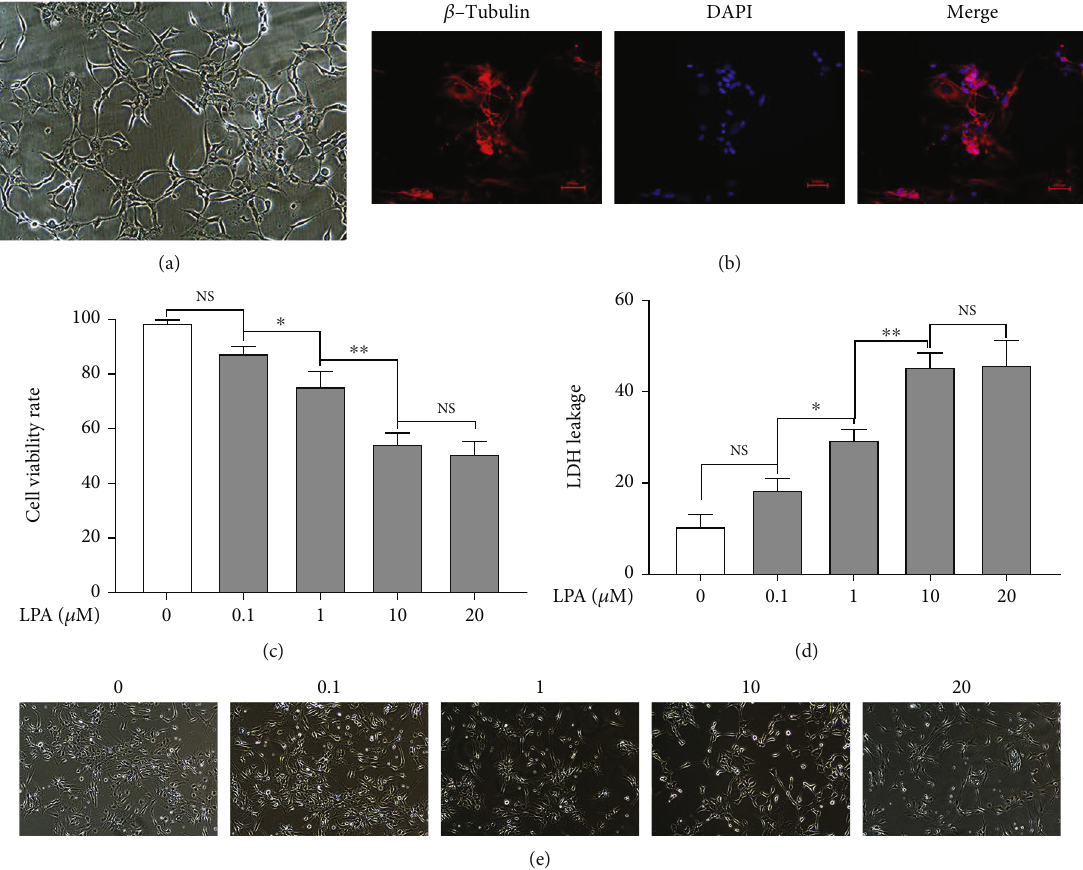
Figure 2: LPA e ff ects on cell viability and cytotoxicity in spinal cord neurons. (a) Observation of primary spinal cord neurons with microscope (100x). (b) The expression of β -tubulin in spinal cord neurons were measured by Immuno fl uorescence (200x). (c, e) spinal cord neurons were treated with di ff erent concentrations of LPA for 24 h, the cell viability was measured by the 3-(4,5-dimethylthiazol-2- yl)-2,5-diphenyl tetrazolium bromide (MTT) assay, the LDH release was measured by LDH assay kit. (d) Cell viability was observed by microscope (100x). Asterisks indicate statistical signi fi cance ( ∗ p < 0 : 05 , ∗∗ p < 0 : 01